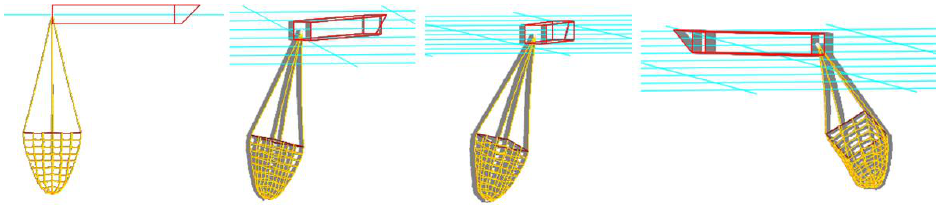
Figure 28. Shape changes of rigid truss trawl in rotating towing under fixed angular velocity at v =